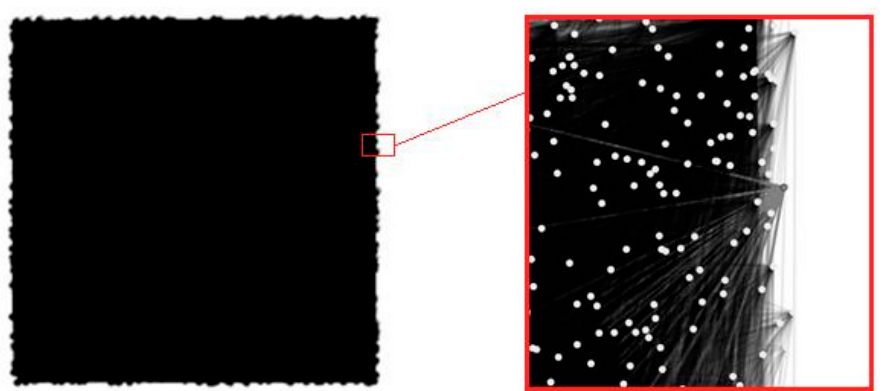
Figure 3. Default network visualization after import into Gephi (14,788 hashtags and 363,525 edges). Source: Own processing.